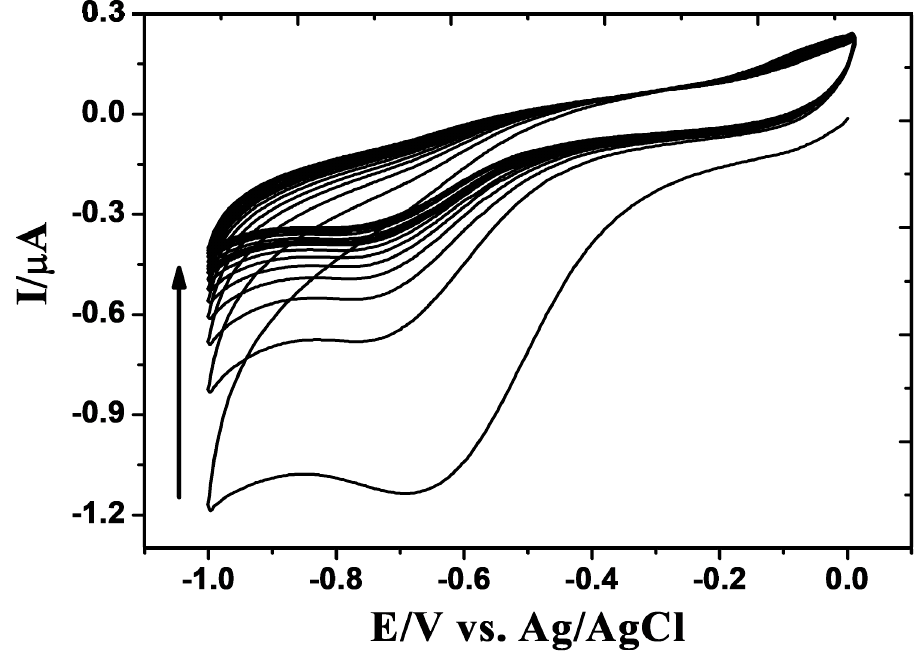
Figure 1. Repetitive cyclic voltammetry (CV) synthesis of the reduced graphene oxide/glassy carbon electrode (rGO/GCE) from graphene oxide in 0.04 M Britton–Robinson buffer solution (pH 5.25) at a scan rate of 50 mV·s − 1 .